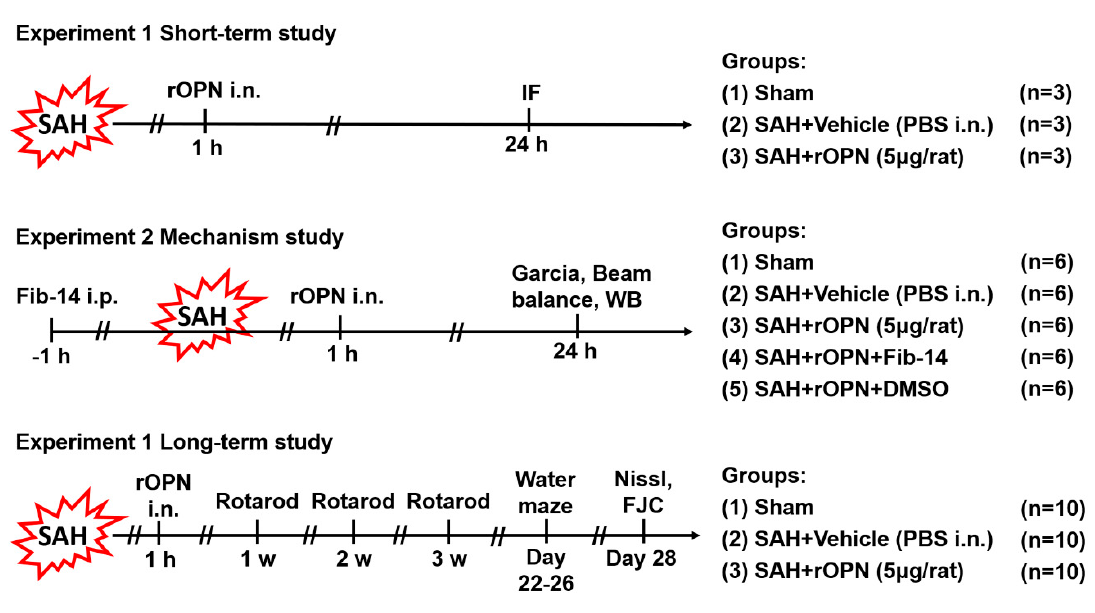
Figure 1. Experimental design. SAH, subarachnoid hemorrhage; WB, western blot; PBS, phosphate-buffered saline; IF, immunofluorescence; rOPN, recombinant osteopontin; i. n ., intra nasal administration; Fib-14, focal adhesion kinase (FAK) inhibitor 14; i.p., intraperitoneal administration; DMSO, dimethyl sulfoxide; FJC, Fluoro-Jade C.